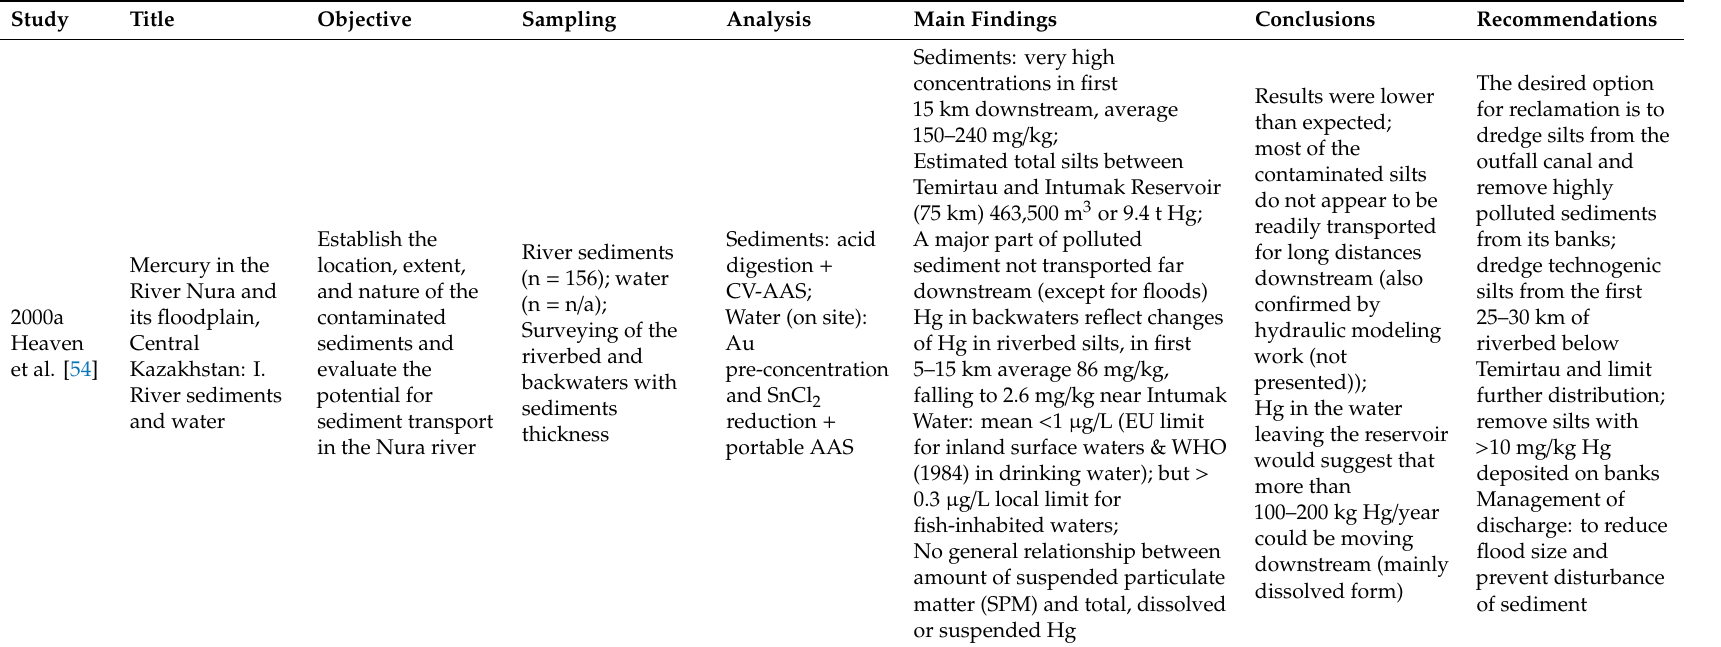
Table 2. Summary of literature on Hg contamination in